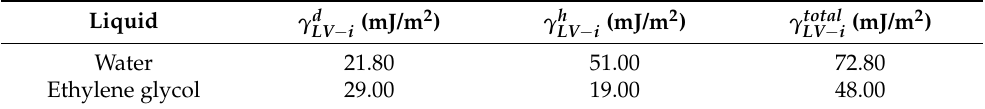
Table 4. Values of the components (dispersive and polar) for the surface tension of both test